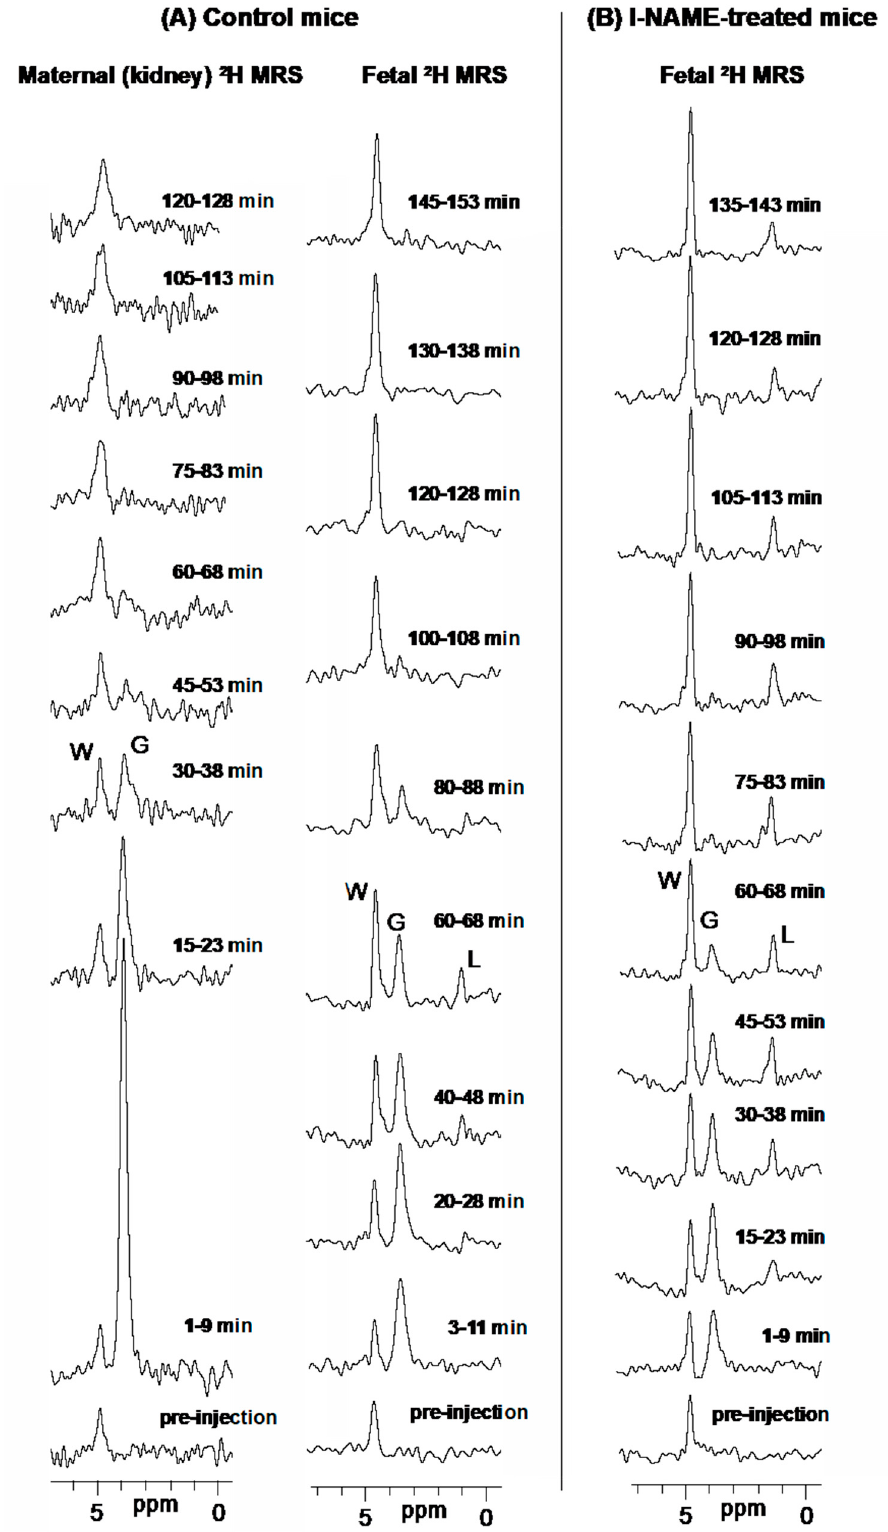
Figure 1. Representative 2 H MRS time-series arising after intravenous administration of 2 H 6,6 ′ -glucose to control ( A ) and l-NAME-treated ( B ) pregnant mice. The columns present localized spectra extracted from MRSI data from the indicated regions and at the indicated post-injection time-points (ranges indicate the extent of the MRSI signal averaging). Signals for 2 H 6,6 ′ -glucose and its metabolic products water and lactate are indicated by letters G, W and L, respectively.